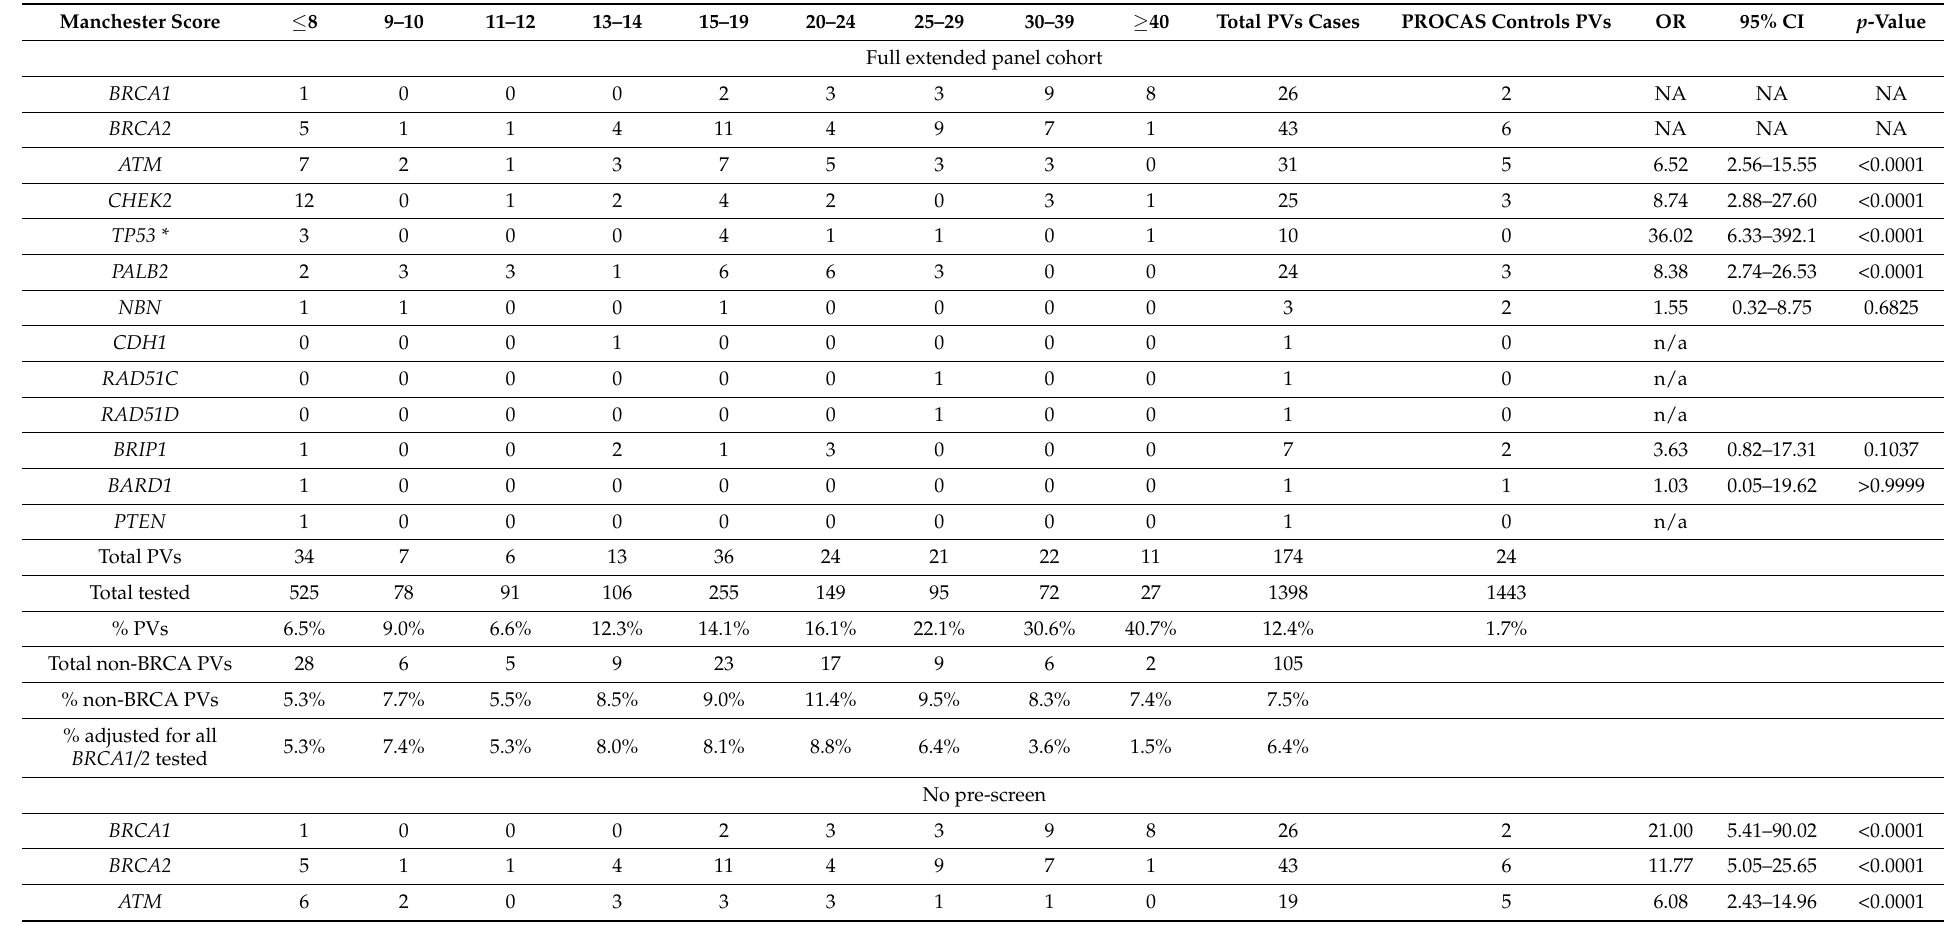
Table 1. Rates of detection of BRCA1/2 and non BRCA breast/ovarian pathogenic variants by Manchester